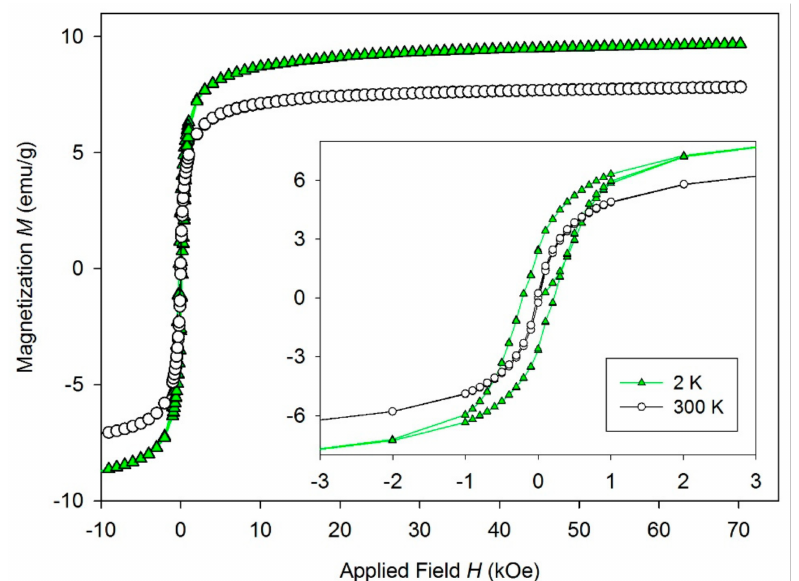
Figure 9. Isothermal hysteresis loops measured at 2 and 300 K for MHNTs. Inset represents low field part of the hysteresis loops.